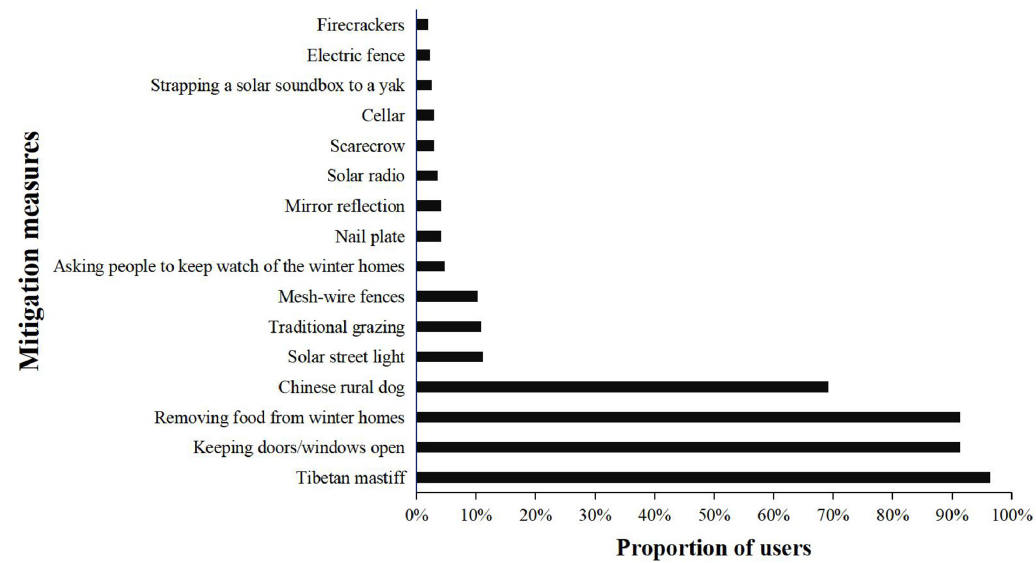
Figure 3. Proportion of users with different bear prevention measures.